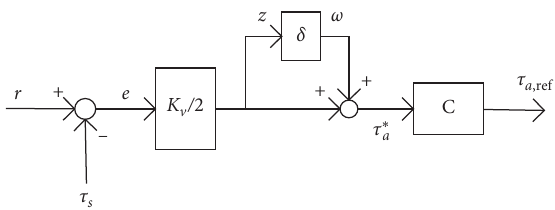
Figure 4: Controller structure with